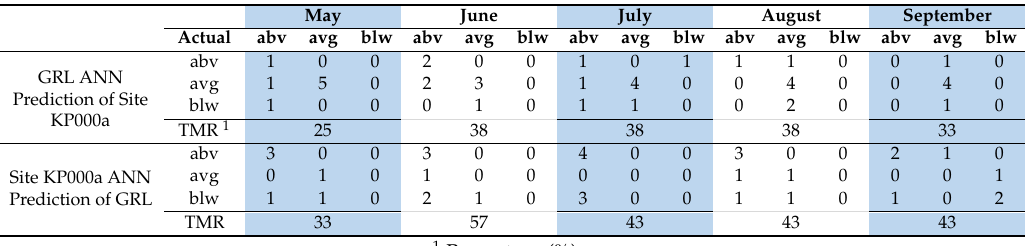
Table 6. Confusion matrices from ANN calibration at one site applied to the other site, showing actual and predicted class membership for the months May through September for the GRL site. AGFM classes are above average (abv), average (avg), and below average (blw) above-ground forage biomass. The total misclassification rate (TMR) for each month is also shown, and is calculated as the number of misclassifications divided by the total number of observations.